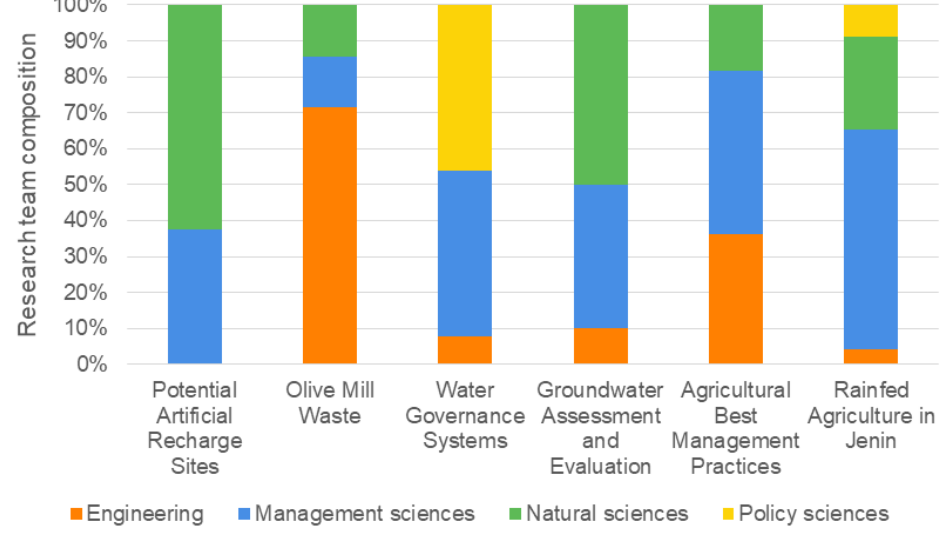
Figure 2. Composition of research teams by disciplinary categories.